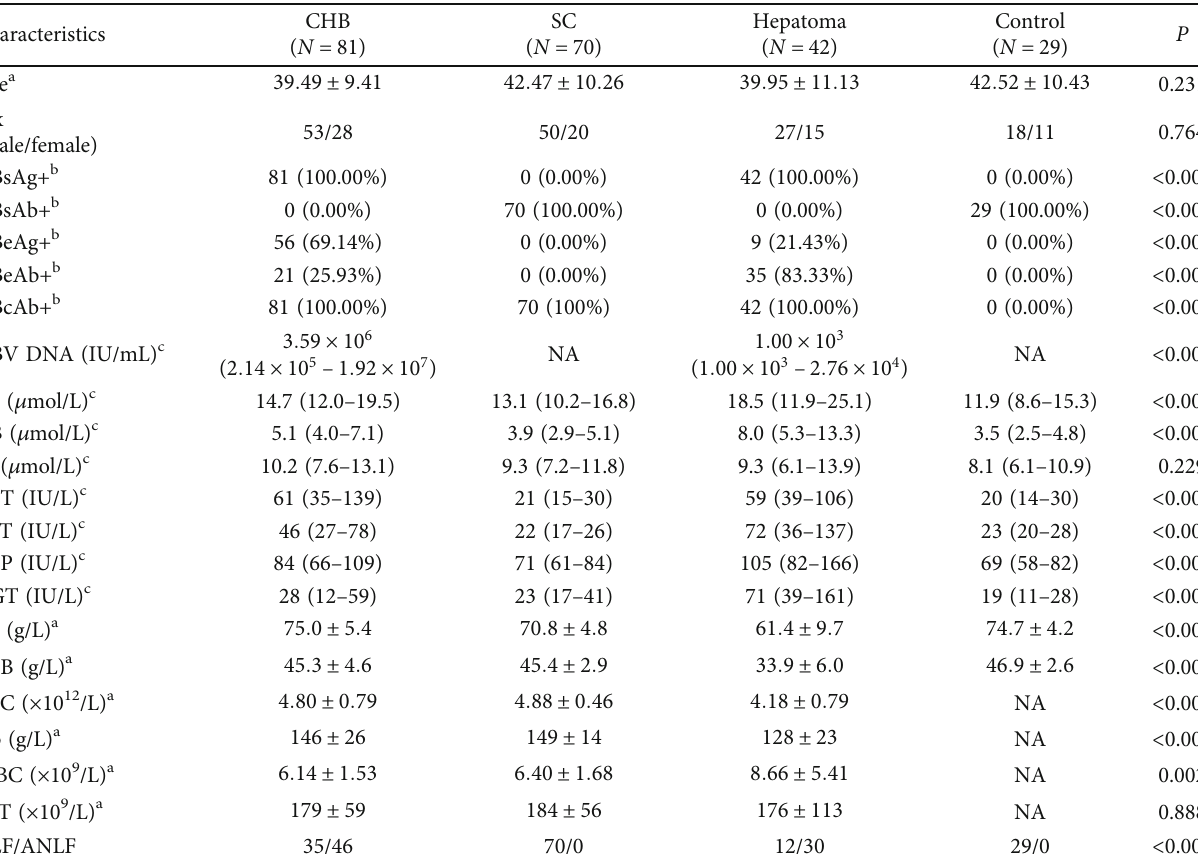
Table 1: Characteristics of the enrolled subjects.